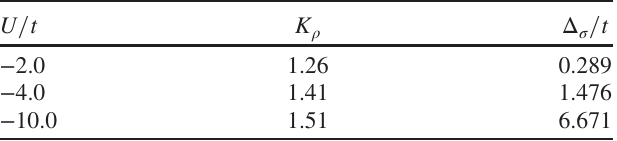
TABLE I. Results from the Bethe ansatz solution of the 1D Hubbard model with attractive interaction at quarter filling. Here, we compute the TLL parameter of charge sector K ρ and the field theory spin gap Δ σ as a function of the interactions. U=t K ρ Δ σ